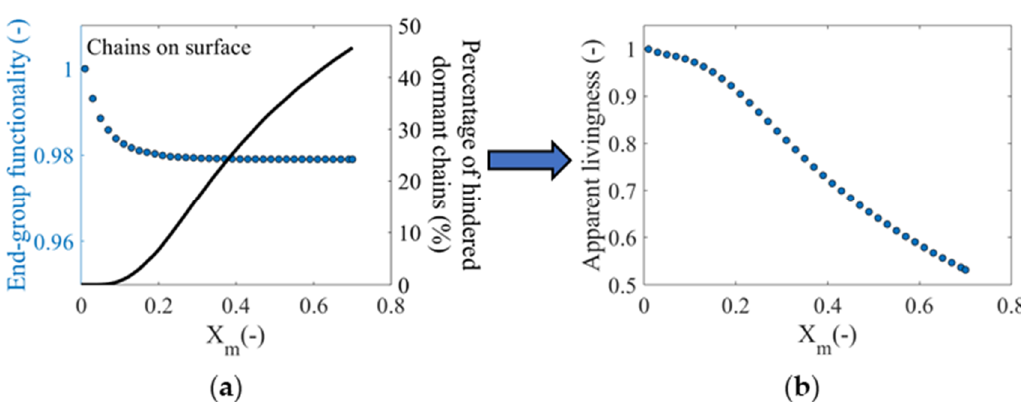
Figure 5. ( a ) Evolution of the end-group functionality of surface-tethered dormant chains as well as the percentage of dormant chains that become hindered from RDRP activation (-growth-deactivation) within the polymer layer due to shielding as a function of monomer conversion ( X m ). ( b ) By combining both characteristics from ( a ), it is possible to determine the evolution of a new molecular property, the apparent livingness of the polymer layer. This property refers to the actual fraction of surface-tethered dormant chains within the polymer layer that can participate in additional propagation events. Results are based on the same (reference) reaction conditions (translational mode) as in Figure 4 and the kinetic parameters in Table 1.